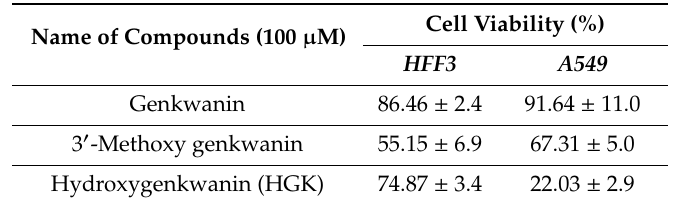
Table 1. Cytotoxic effects of the compounds Genkwanin, 3 (cid:48) -Methoxy genkwanin, and hydroxygenkwanin (HGK).